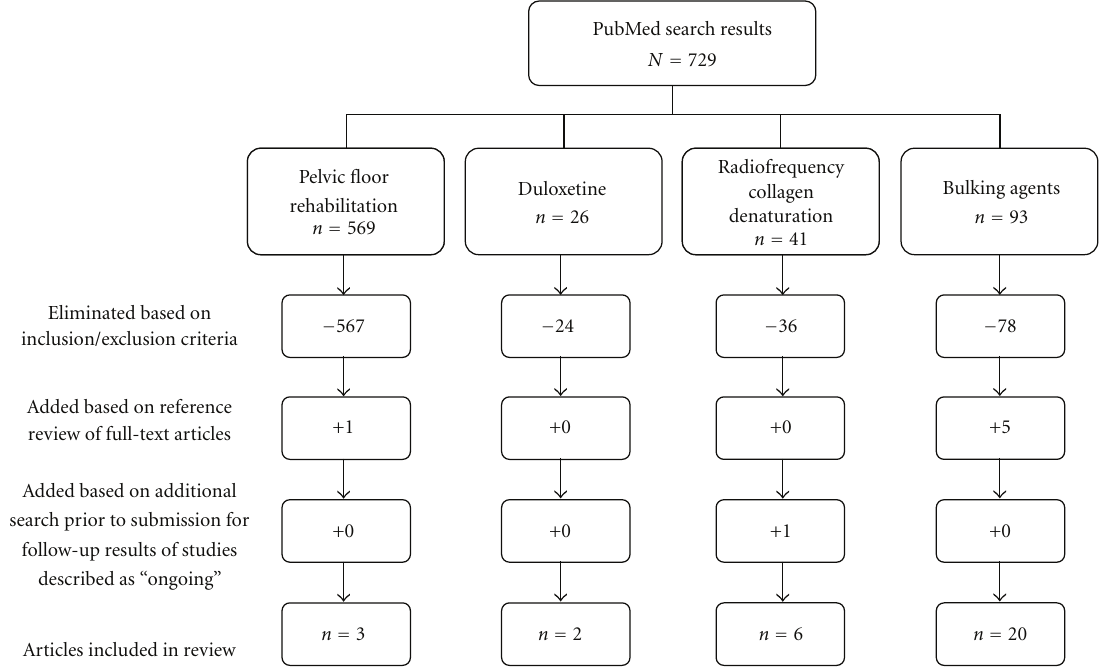
Figure 1: Search results and article